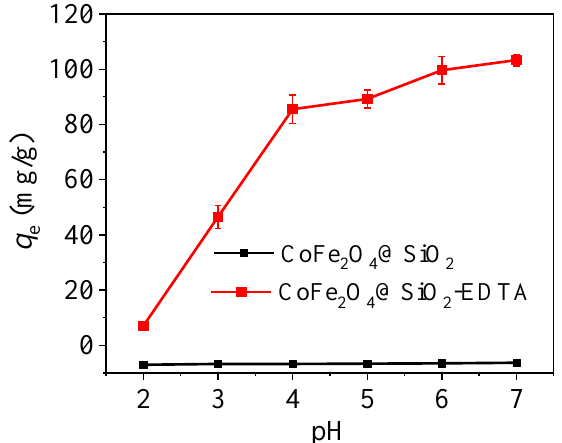
Figure 10. Effect of pH on the removal of Hg(II) by CoFe 2 O 4 @SiO 2 -EDTA as adsorbent (dosage = 0.1 g/L, C 0 = 20 mg/L, t = 6 h, T = 298 K).